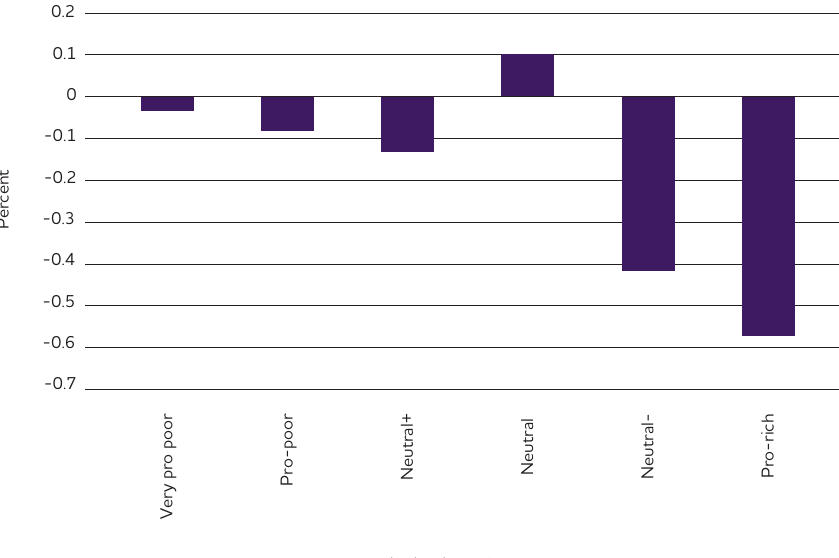
Figure 18: Real Budget Change by English Local Authorites 2010-14 by Dist ributional Character of Service (percent, excluding education)